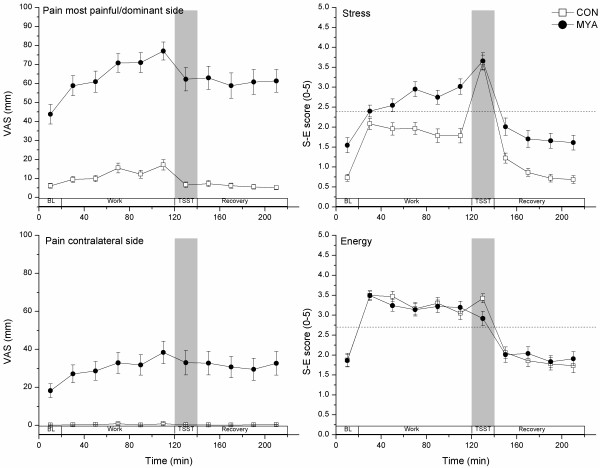
Subjective ratings (mean ± SEM) during Baseline (BL), work, TSST and recovery periods. The neutral points for Stress and Energy are indicated by the horizontal dashed lines.